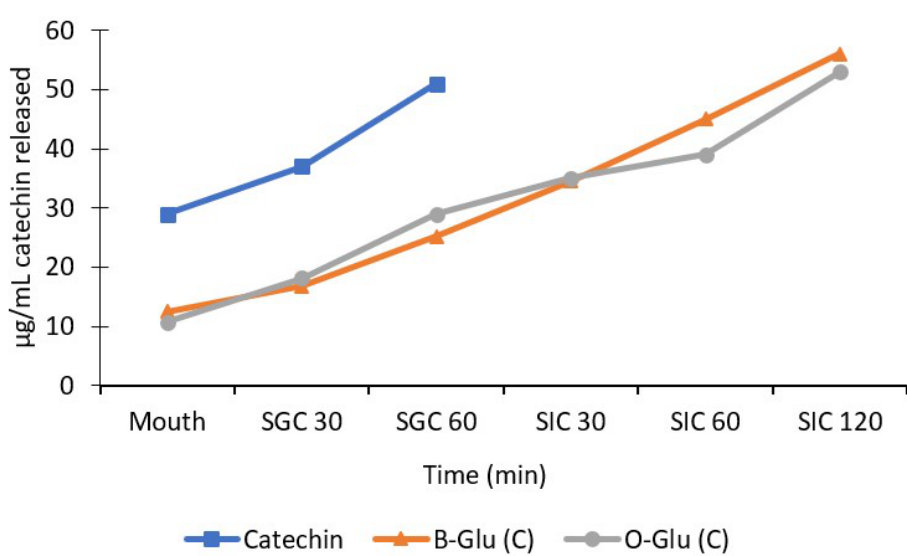
Figure 5. In vitro release pattern of catechin from the β -glucan matrix. SGC (simulated gastric condition) at 30 and 60 min of incubation; SIJ (simulated intestinal condition) at 30, 60, and 120 min of